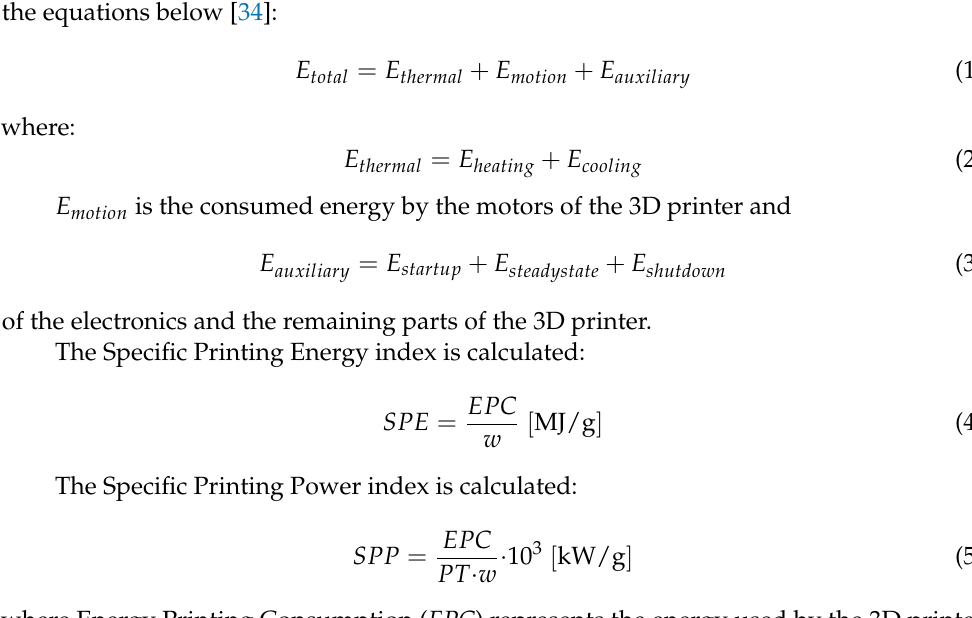
Figure 2. Three-dimensional printing with the FFF MEX process: 3D printing settings visual repre- sentation, their levels are depicted on the right side of the figure. The geometry of the specimens manufactured with the FFF MEX 3D printing process following the ASTM D790-02 standard.